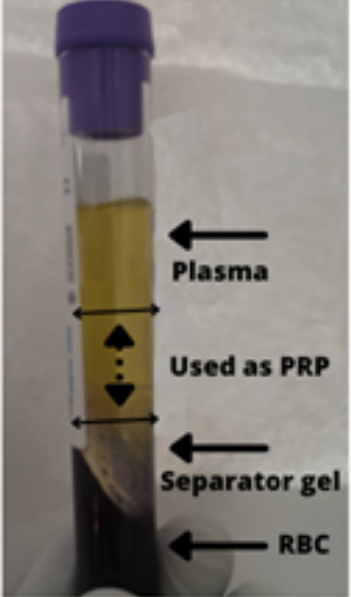
Figure 1. Fractional separation of PRP using gel separator tubes: the plasma or platelet-poor plasma fraction was discarded. The injected fraction or PRP is outlined with an interrupted arrow. Approx- imately 2 mL was obtained from which 1.5 mL was injected in the vocal fold and 0.5 mL was sent for platelet count. PRP = platelet rich plasma; RBC = red blood cells.